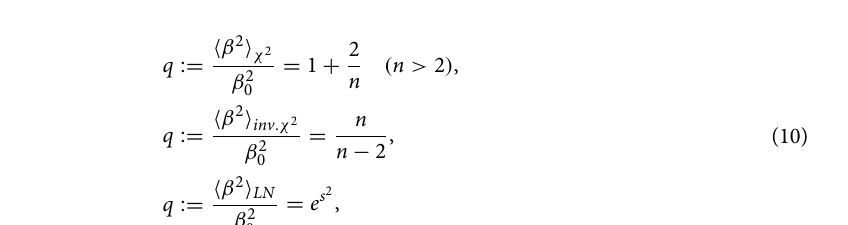
Figure 1. Examples of superstatistical velocity distributions for χ f ) superstatistics, with different values of q top panel, the local equilibrium distribution corresponds to the MB distribution while in the bottom panel, it corresponds to the (1d projected) FD